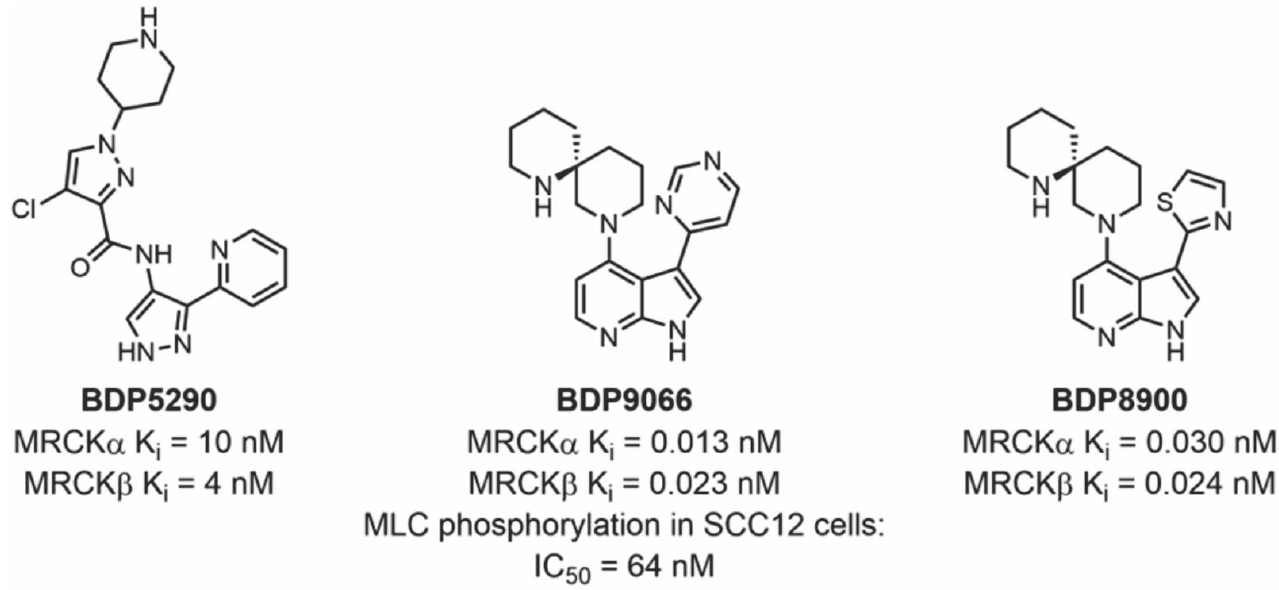
Figure 7. Structures of BDP5290, BDP9066, and BDP8900 with their corresponding enzymatic and cellular activities.